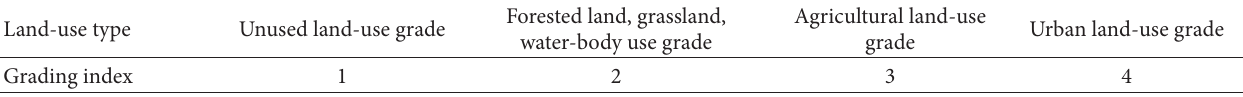
Table 2: Land-use intensity grade.